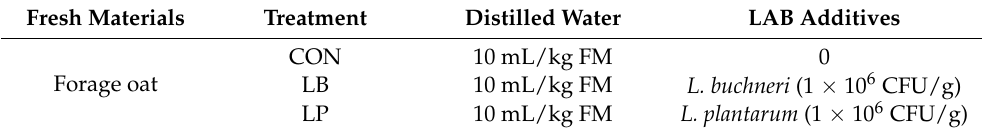
Table 1. The design of the experiment. Fresh Materials Treatment Distilled Water LAB Additives Forage